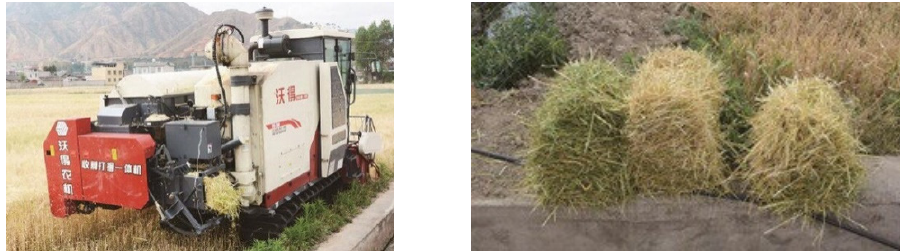
Figure 16. WORLD 9YFL-2300 all-in-one machine for harvesting and